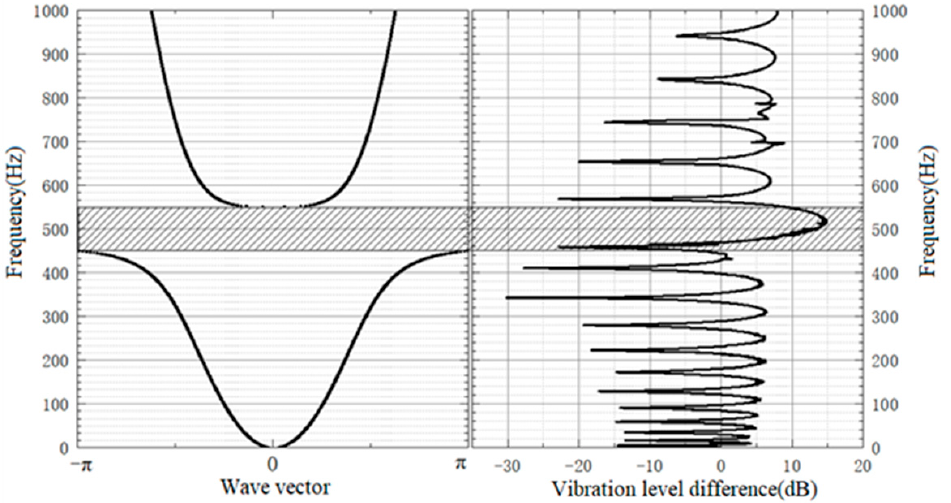
Figure 3. Comparison of energy band structure and vibration transmission characteristics of local oscillator period lines.